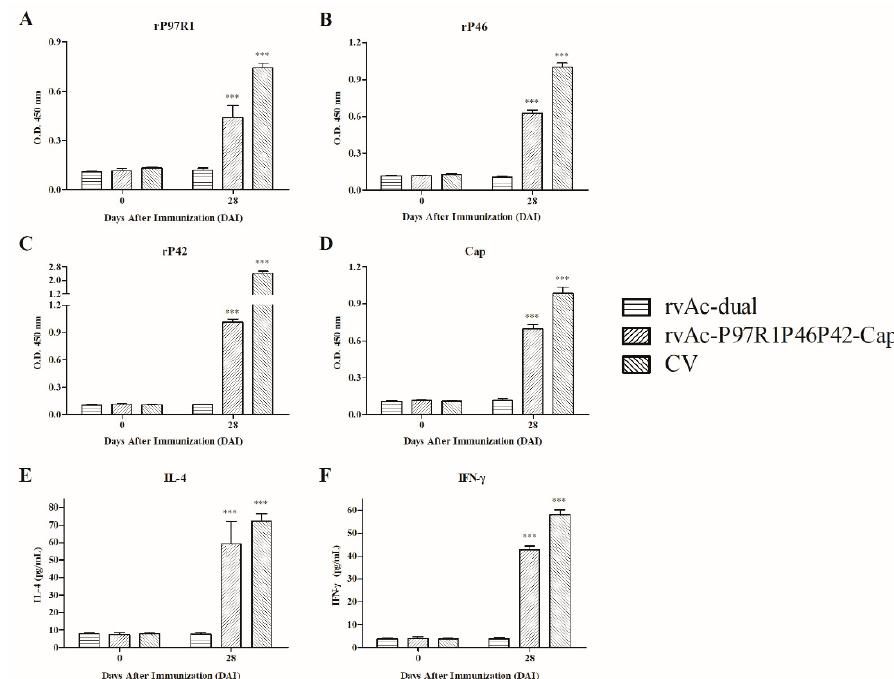
Figure 7. Analysis of immunogenicity in piglets. IgG response in piglet immunization against four recombinant proteins ( A – D ). ( A ) Total IgG level against rP97R1; ( B ) Total IgG level against rP46; ( C ) Total IgG level against rP42; ( D ) Total IgG level against Cap. The Y axis represents the mean OD 450 of serum samples collected at 0 and 28 DAI. Quantitative analysis of interleukin 4 (IL-4) and interferon gamma (IFN- γ ) levels in sera from immunized piglets ( E , F ). ( E ) Content of cytokine IL-4; ( F ) Content of cytokine IFN- γ . The Y axis represents the mean content of cytokine in serum samples collected at 0 and 28 DAI. All analyses were performed in triplicate, and the error bars demonstrate standard deviations (SD). *** p < 0.001, significantly different from the OD value of the rvAc-dual group (Bonferroni test).